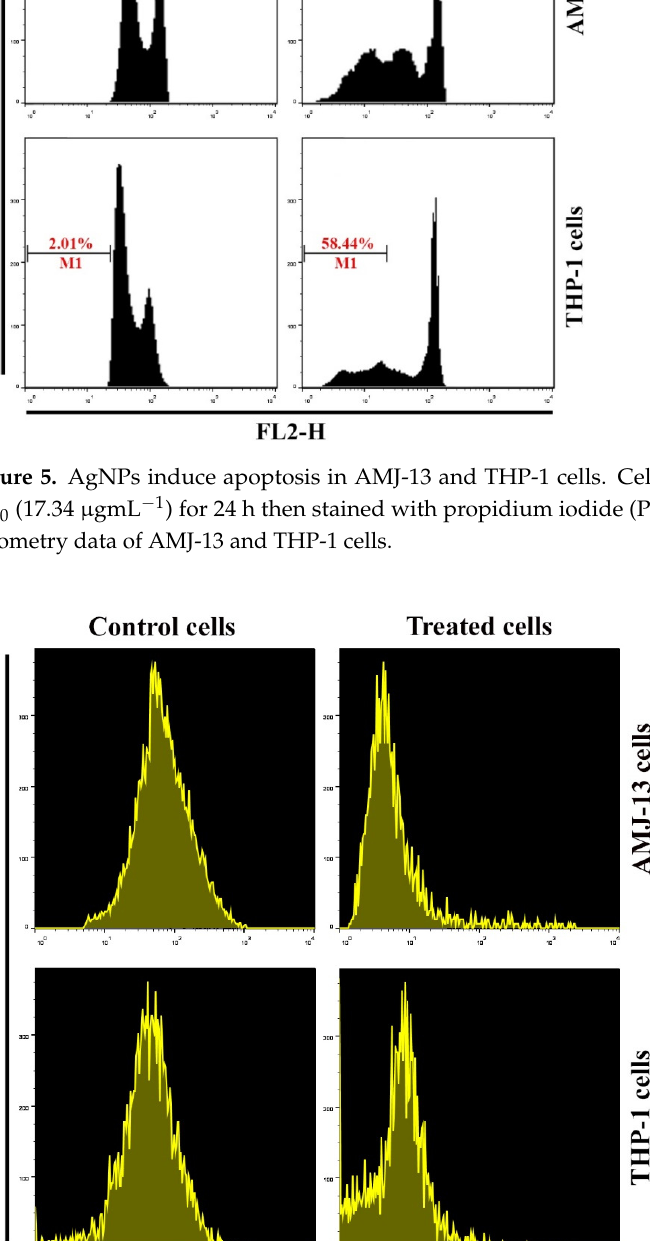
Figure 6. Dysfunction of MMP in AgNPs-treated AMJ-13 and THP-1 cells. Cells were exposed to AgNPs at IC 50 (17.34 μ gmL − 1 ) for 24hr then stained with Rh123 dyes (10 M for 1 h at 37 °C). Flow AgNPs at IC 50 (17.34 µ gmL − 1 ) for 24 h then stained with Rh123 dyes (10 M for 1 h at 37 ◦ C). Flow effects on mitochondrial membrane